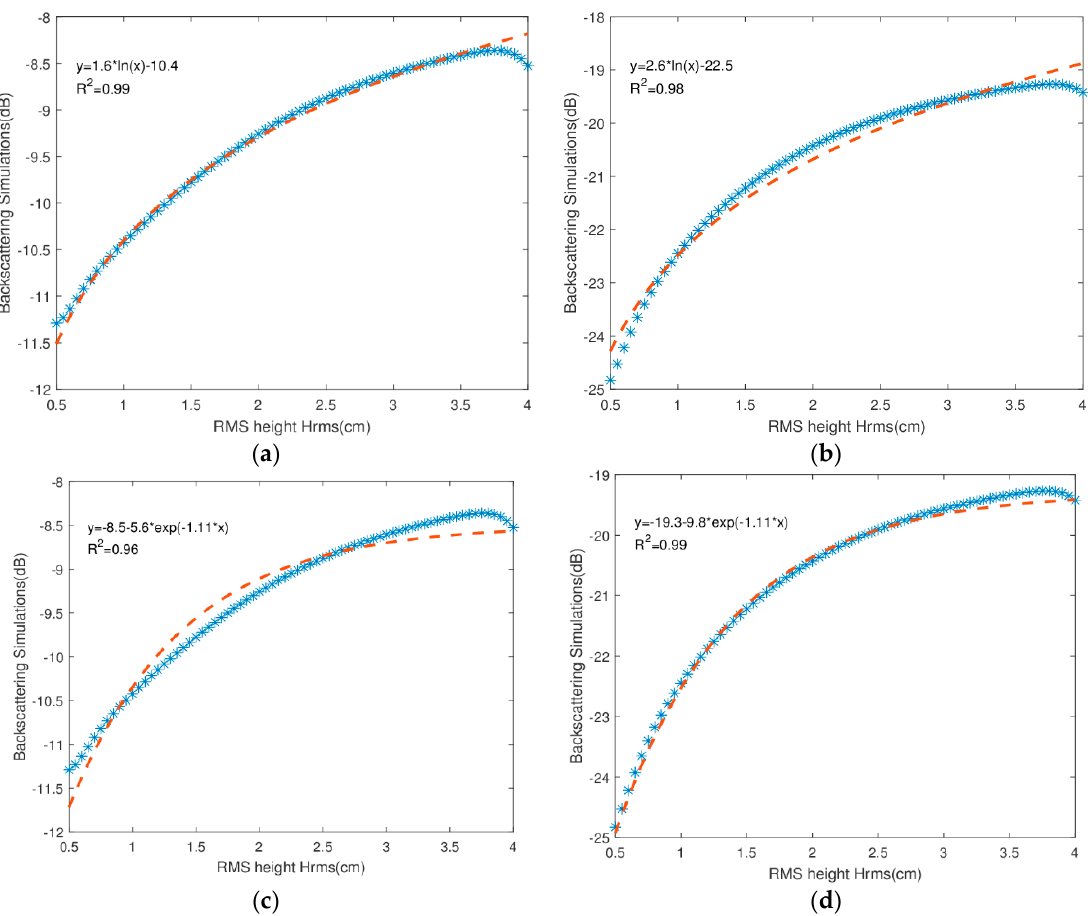
Figure 3. CIEM simulations of the backscattering signal and Hrms , empirical correlation length lopt in different fitting relationships (logarithmic and exponential) in VV and VH polarizations: ( a ) VV, logarithmic; ( b ) VH, logarithmic; ( c ) VV, exponential; ( d ) VH, exponential.